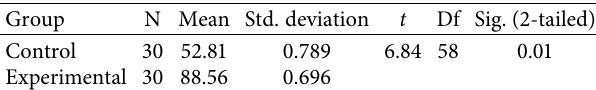
Table 6: Independent-samples t -test results for the differences in the mean scores between the control group and the experimental group on the postapplication of